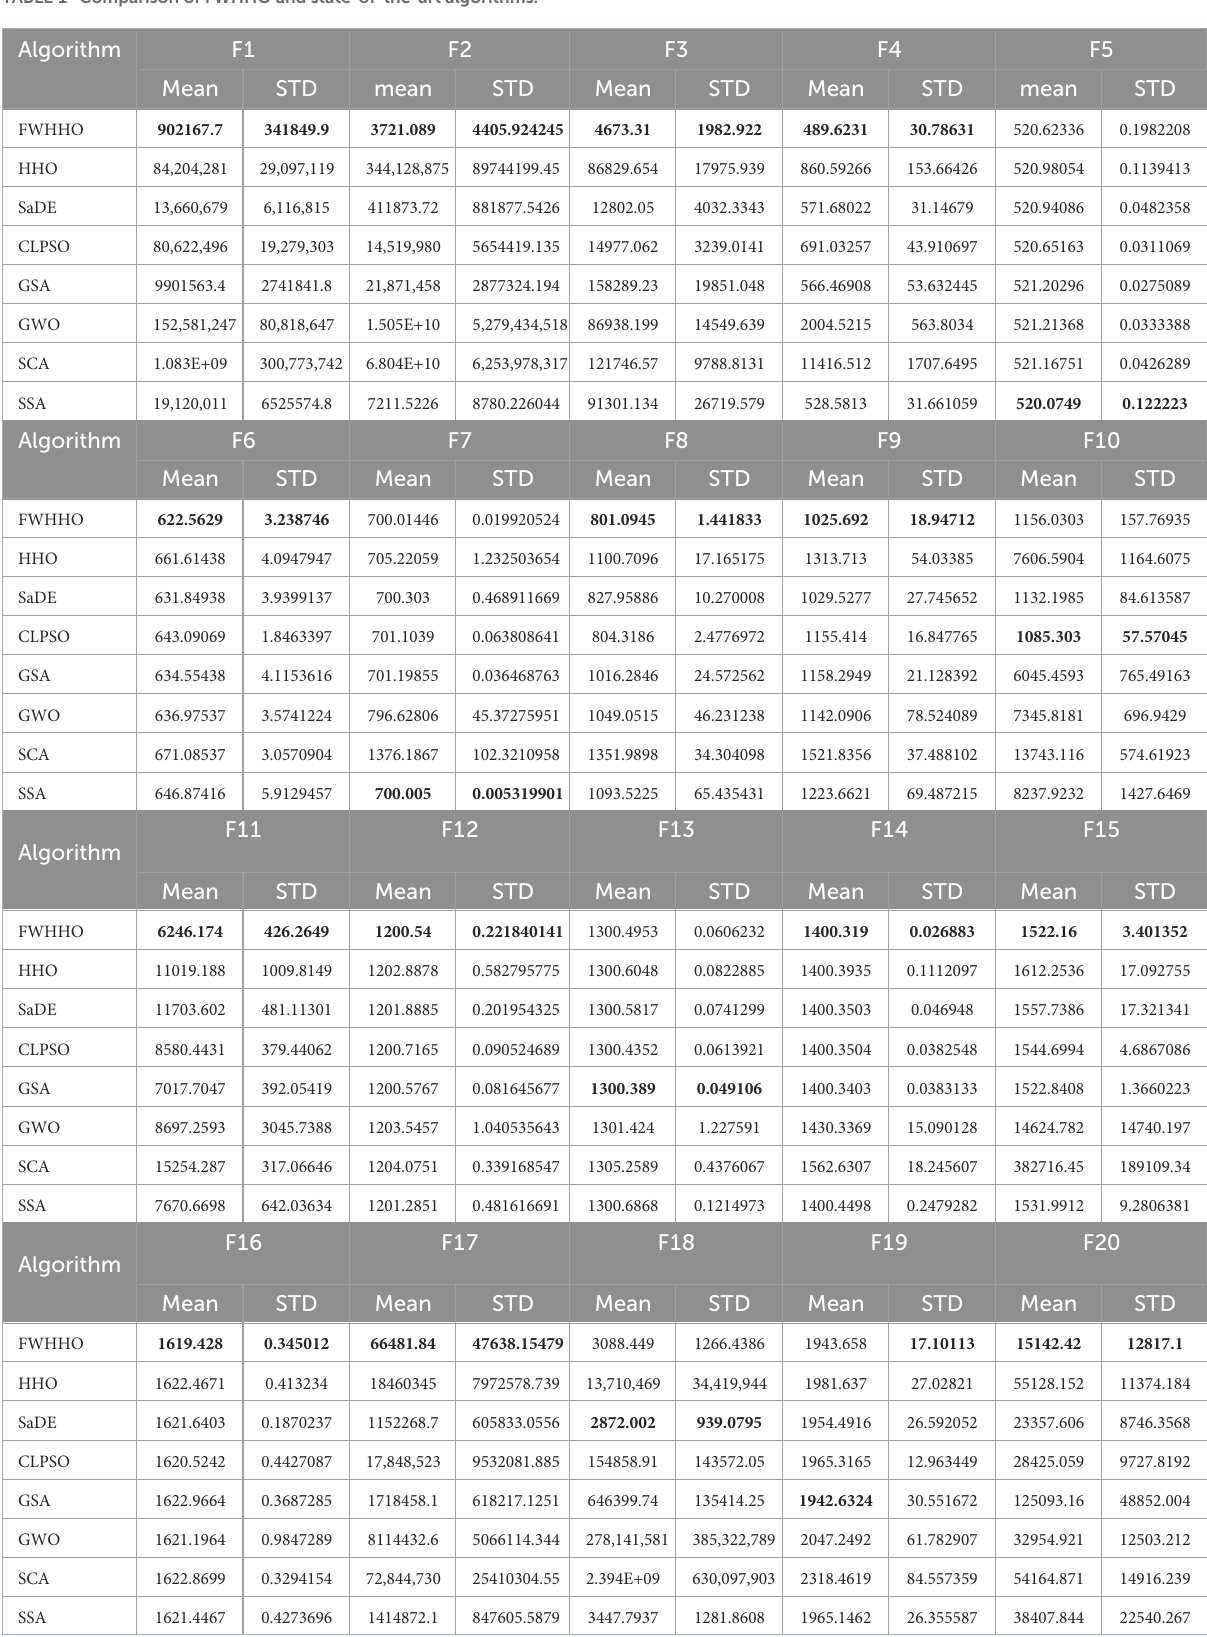
TABLE 1 Comparison of FWHHO and state-of-the-art